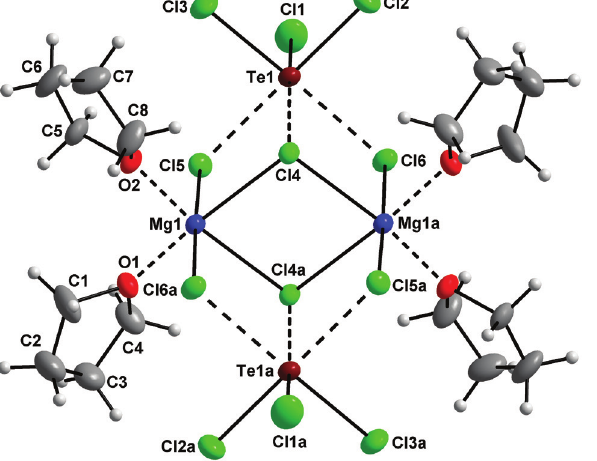
Figure 1 Molecular structure of Te THF·CH Cl showing 30% probability ellipsoids and the crystallo- 2 2 graphic numbering scheme.